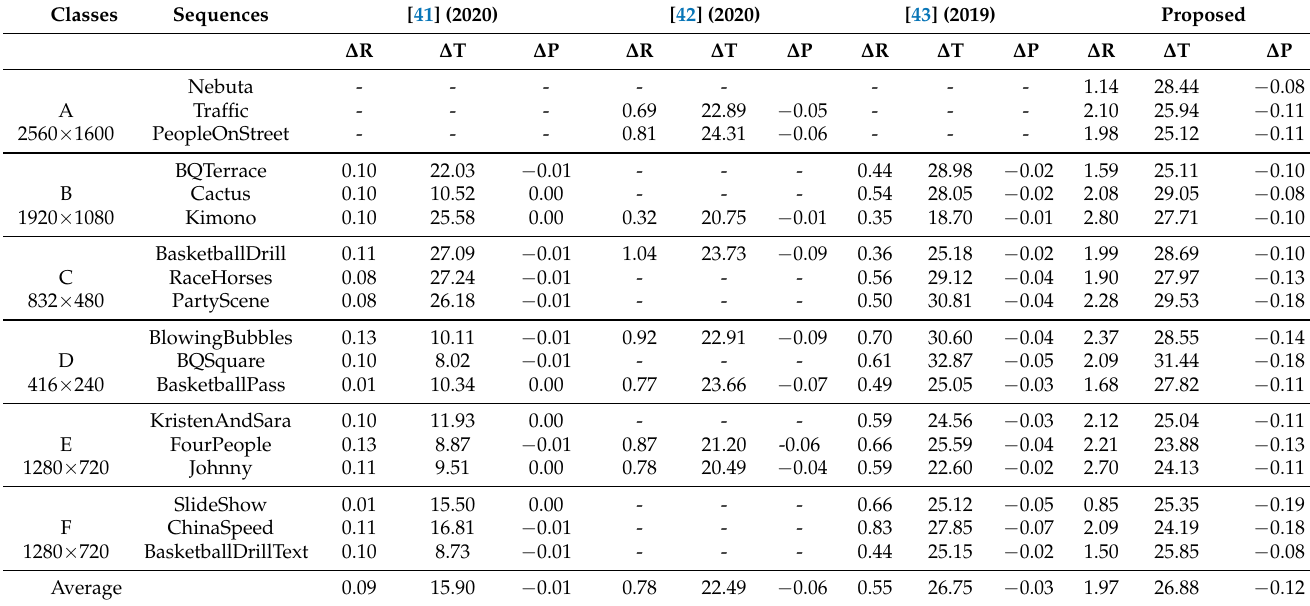
Table 5. Proposed Model vs Existing